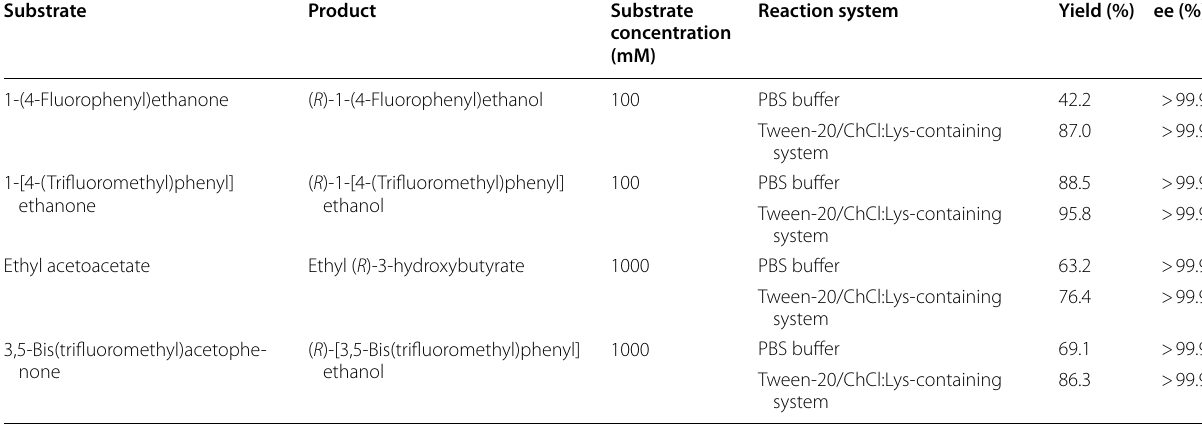
Reaction conditions: 0.063 g (DCW)/mM E. coli cells, 15% (v/v) isopropanol, 0.6% (w/v) Tween-20, 4% (w/v) ChCl:Lys, 30 ºC and 200 rpm, reaction for 18 h